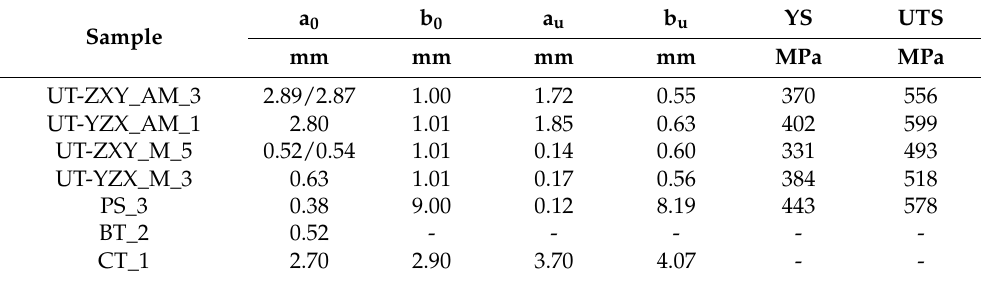
Figure 13. ( a ) Engineering stress-strain curves of different sample geometries and orientations, ( b ) force-displacement curve of the biaxial test, ( c ) force-displacement curve of the compression test. Table 3. Results of tensile, plane strain, biaxial and compression testing including the dimensions of the samples before and after testing, yield strength and ultimate tensile strength (if applicable). Sample